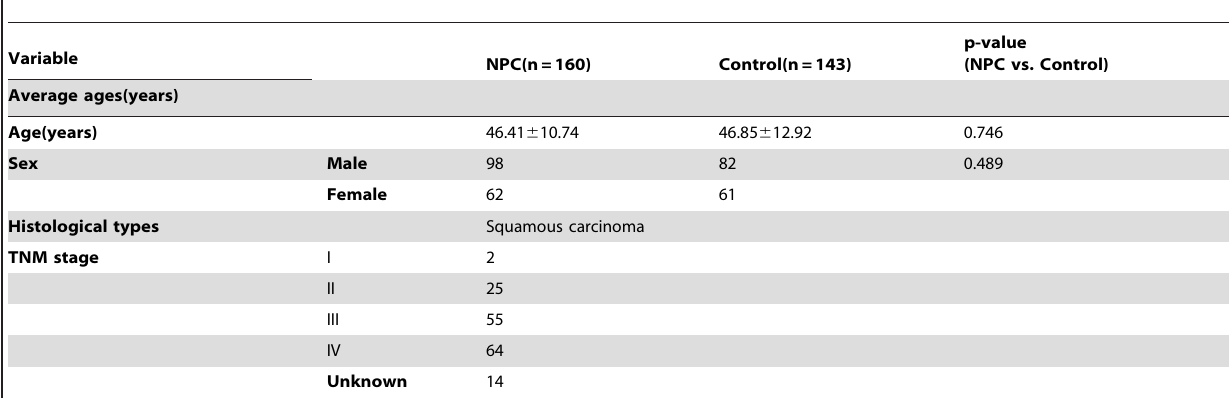
Table 1. Demographic and clinical features of NPC patients and non-cancerous subjects.